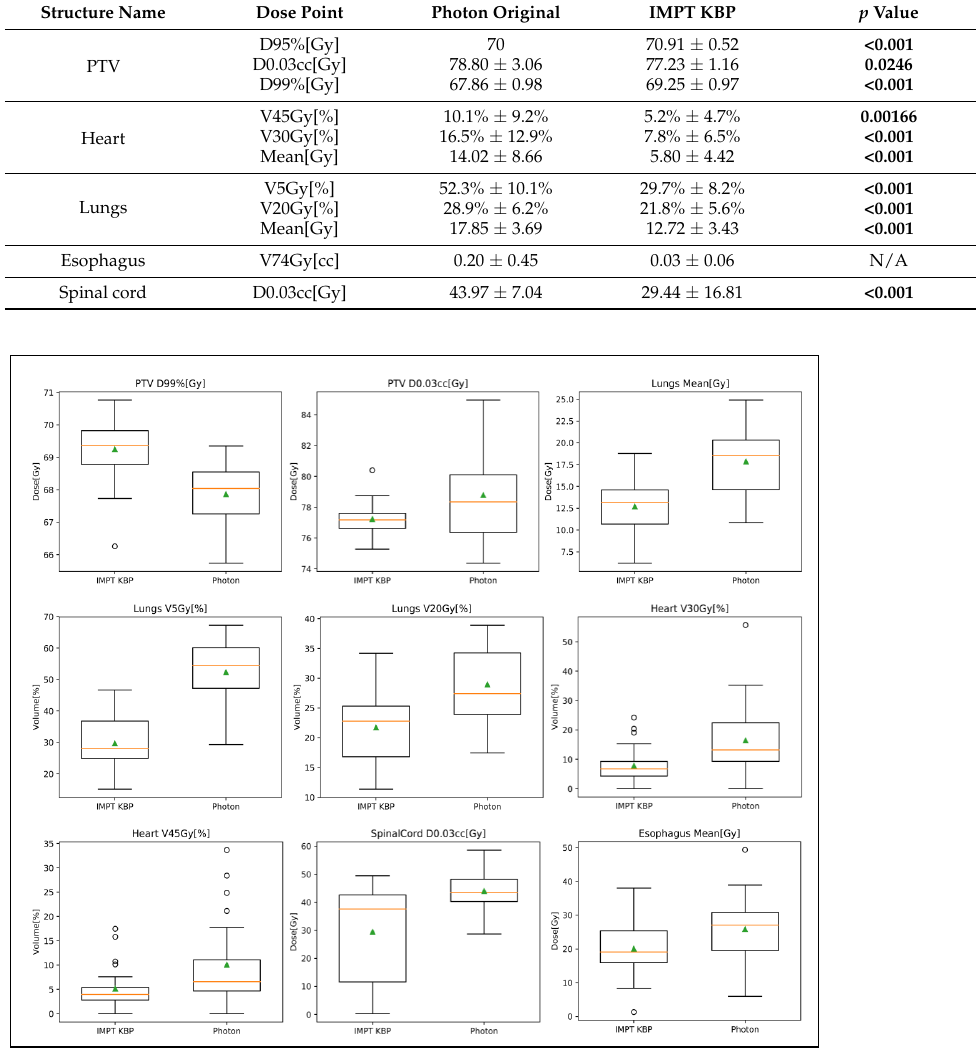
Figure A1. Box plots of dosimetric comparison for IMPT KBP versus photon plan for 40 testing cases originally treated with IMRT. (Orange lines indicate the average values and the green triangles indicate the median values; Circles indicate potential outliers.)